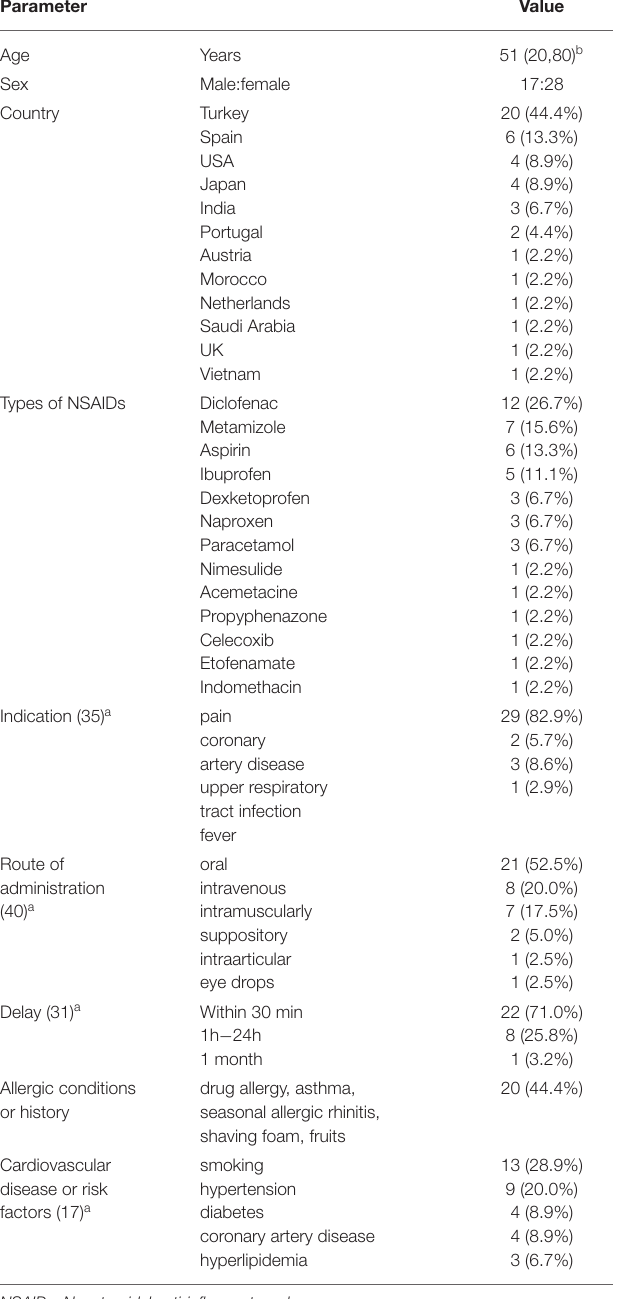
TABLE 2 | Clinical symptoms and laboratory findings of NSAIDs-induced Kounis